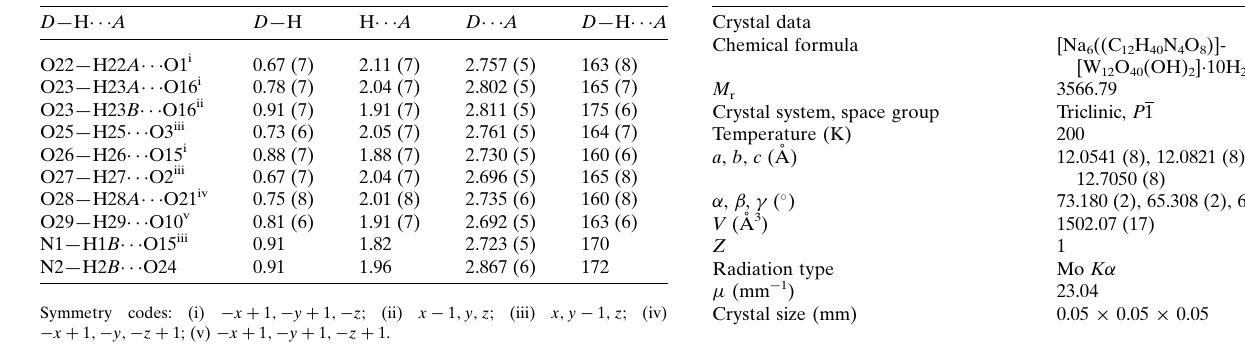
Table 1 Hydrogen-bond geometry (A˚ , (cid:5) ).